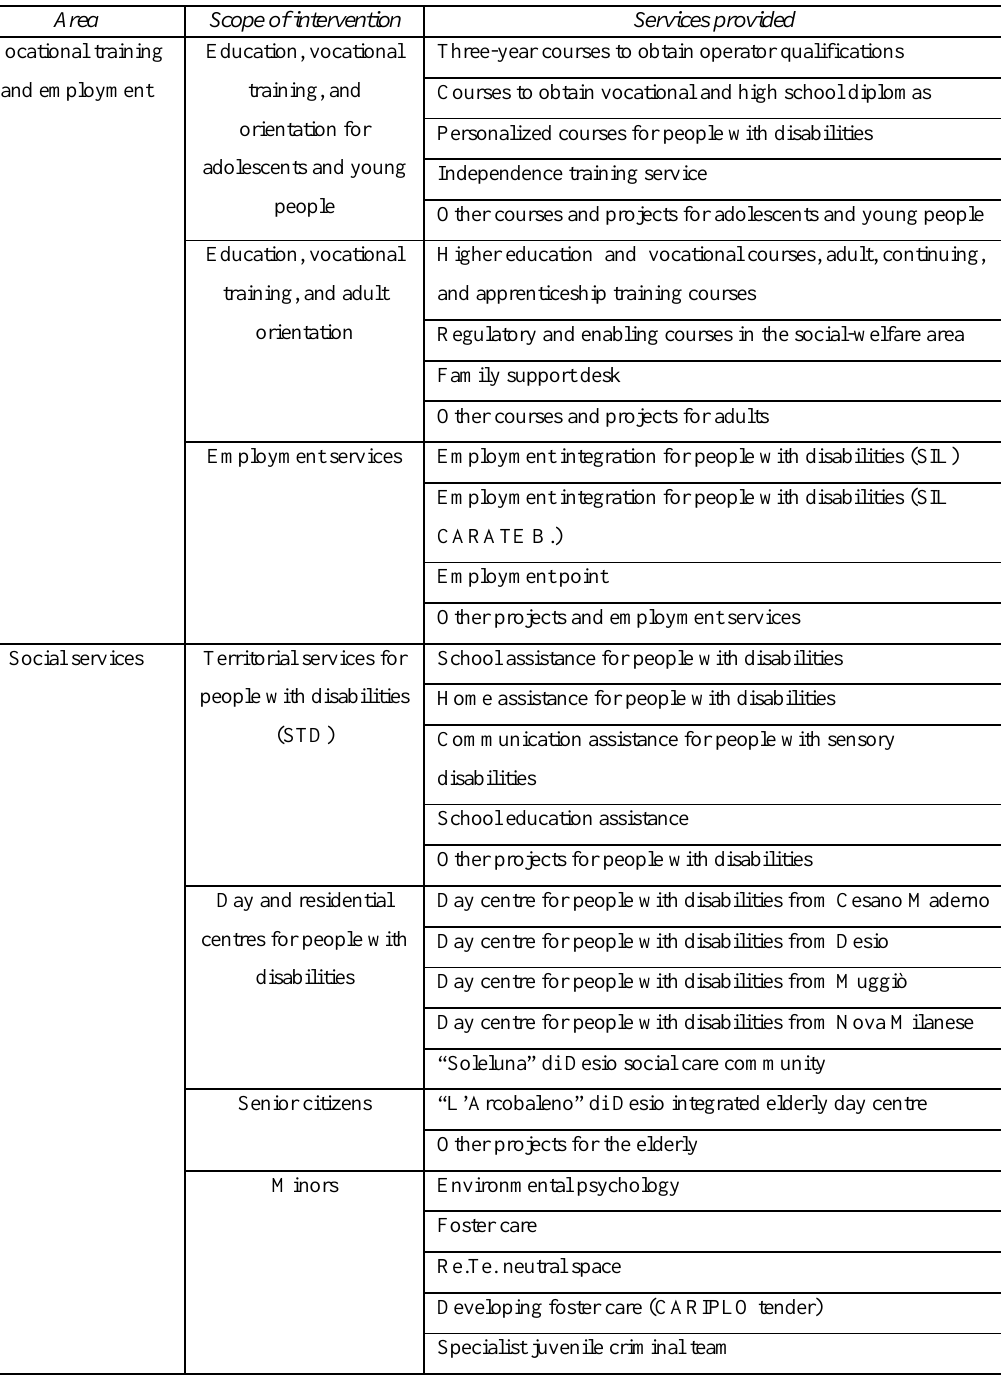
Table 3: Areas, Scope and Services Map Area Services